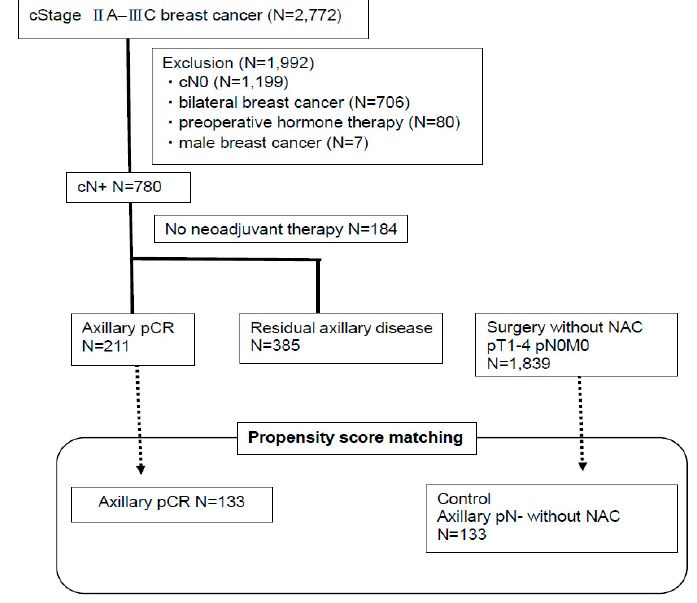
Figure 1. Flow diagram of the study. Cancers 2020 , 12 , x